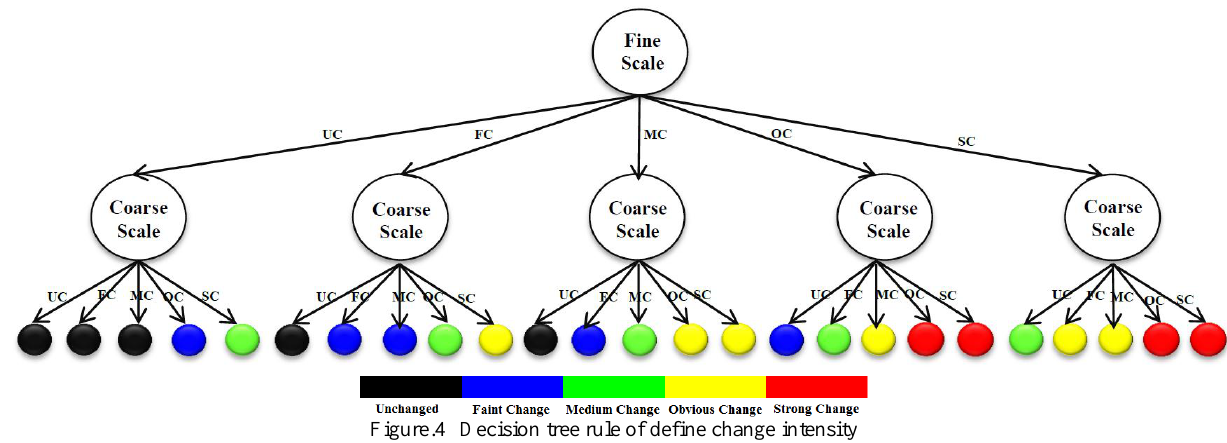
Figure.4 Decision tree rule of define change